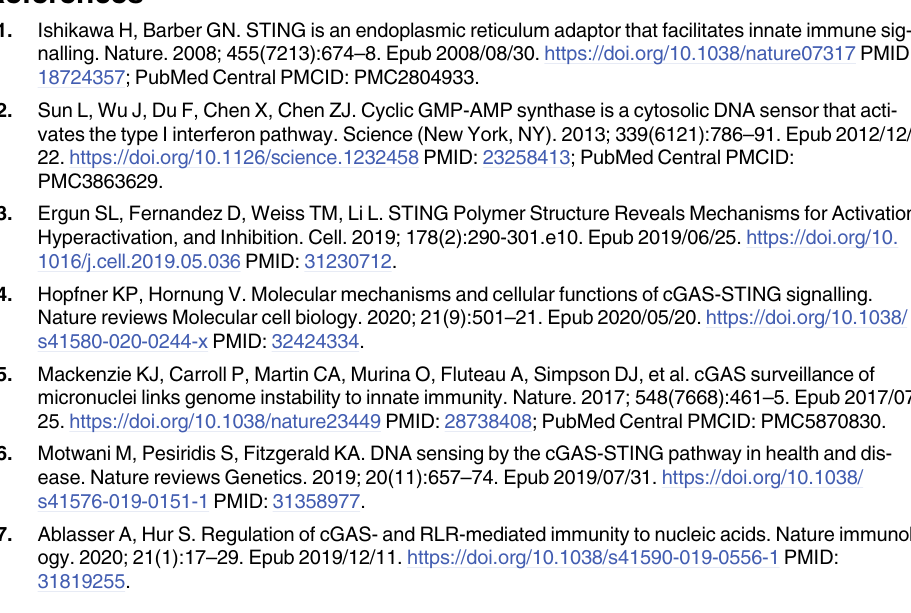
S1 Data. Raw data. Excel spreadsheet containing, in separate sheets, the underlying numerical data and statistical analysis for Figs 1A, 1B, 1C, 1G, 1H, 1I, 1J, 1K, 2B, 2C, 2F, 2G, 3A, 3B,